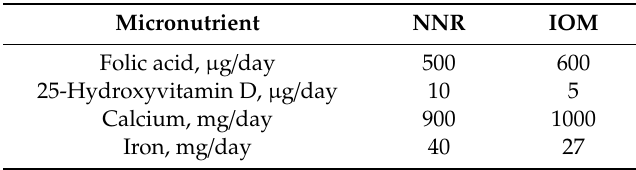
Table 5. Recommendation of specific micronutrients in